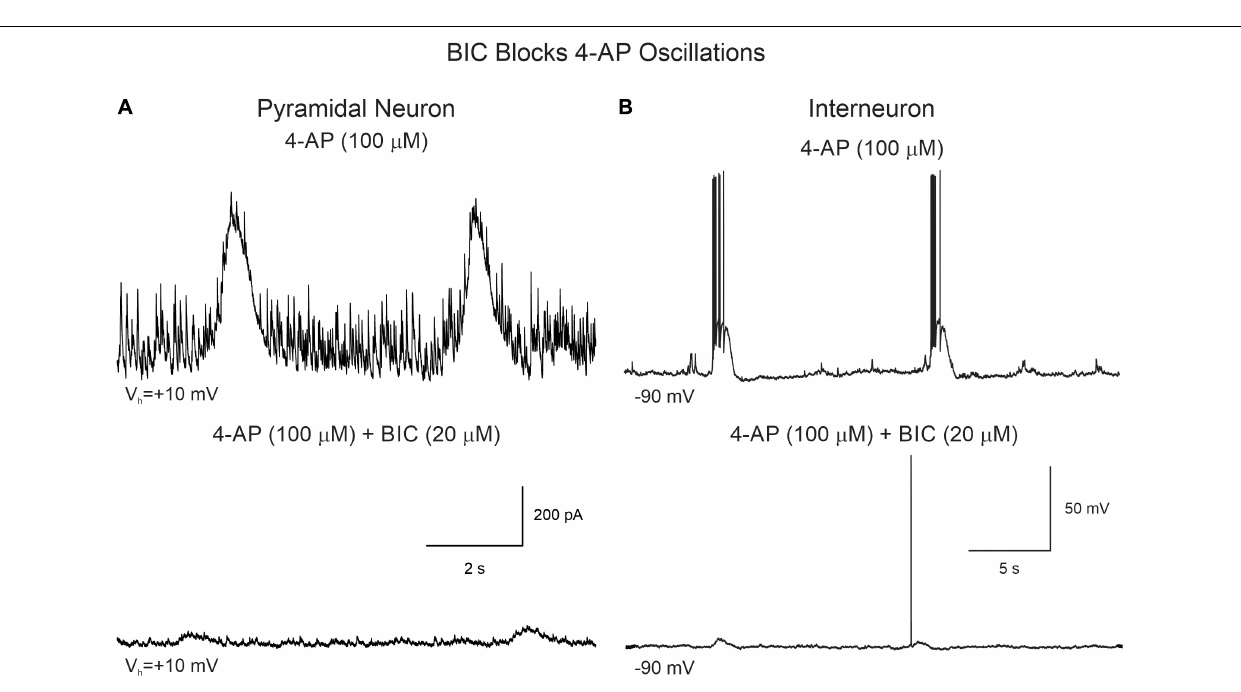
Frontiers in Cellular Neuroscience |